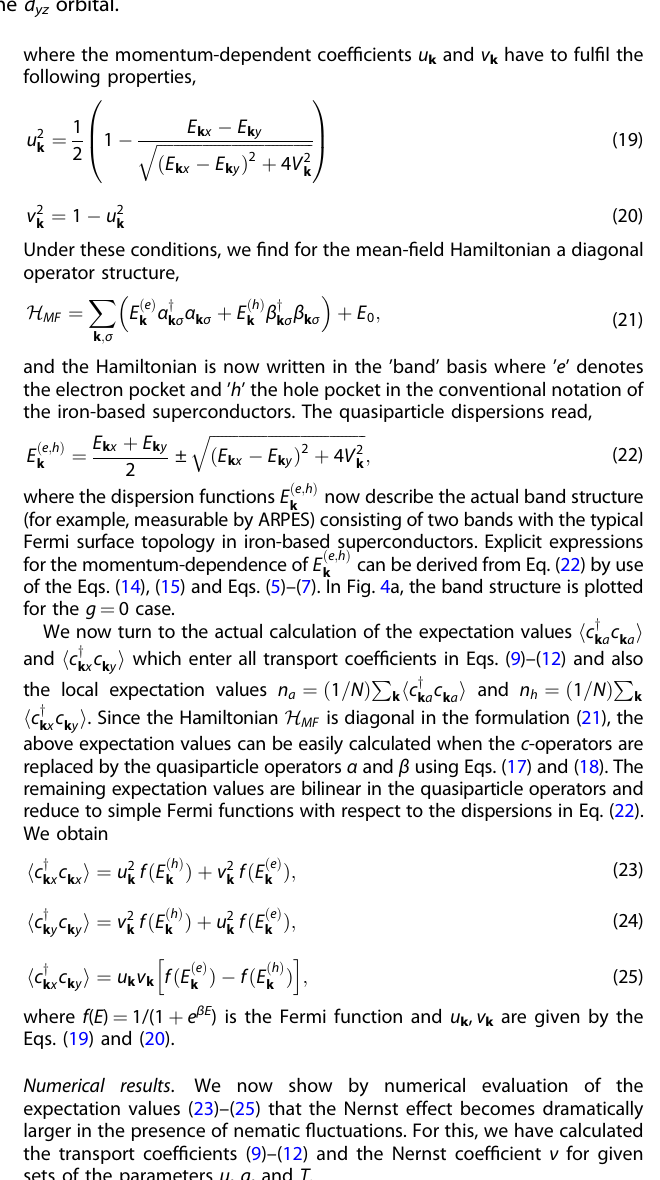
Fig. 4 Modelled dispersion and occupation. Dispersion and occupation numbers of electrons in the d xz (blue solid lines) and in the d yz (green solid lines) orbital states plotted in momentum space along the k x direction. The chemical potential is fi xed to μ = 1.2. a Difference between the orbital dispersions and the chemical potential, ε k , a − μ , calculated from Eqs. (5), (6). Since V t vanishes along the k x -axis the dispersions ε k , a k correspond in the absence of nematic fl uctuations, i.e. g = 0, to two bands leading to the well-known hole- and electron-like Fermi surface sheets around (0, 0) and ( π , 0). b Orbital occupation numbers (per spin direction) as a function of momentum along the k x -axis in the g = 0 case and a fi nite small temperature k B T = 0.02. Due to the absence of interactions, these expectation values correspond to Fermi functions. c Same quantities for g = 0.2. To highlight their momentum variations due to the nematic fl uctuations, the occupation numbers are plotted between 0.9 and 1.03 for the d xz orbital and between 0 and 0.1 for the d yz